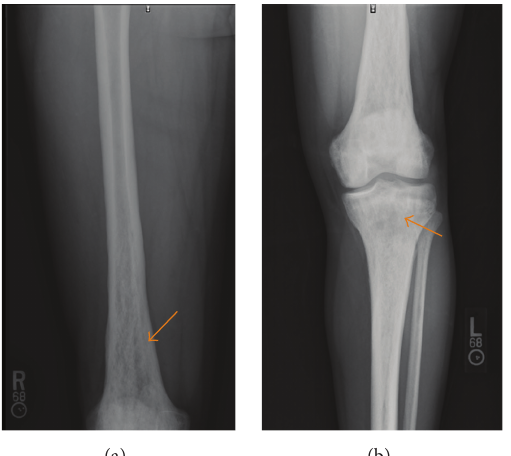
Figure 1: A 35-year-old male with frontal radiographs of the distal right femur and left knee: there is permeative mixed sclerosis and lucency (arrow) in the distal femoral and proximal tibial shafts.